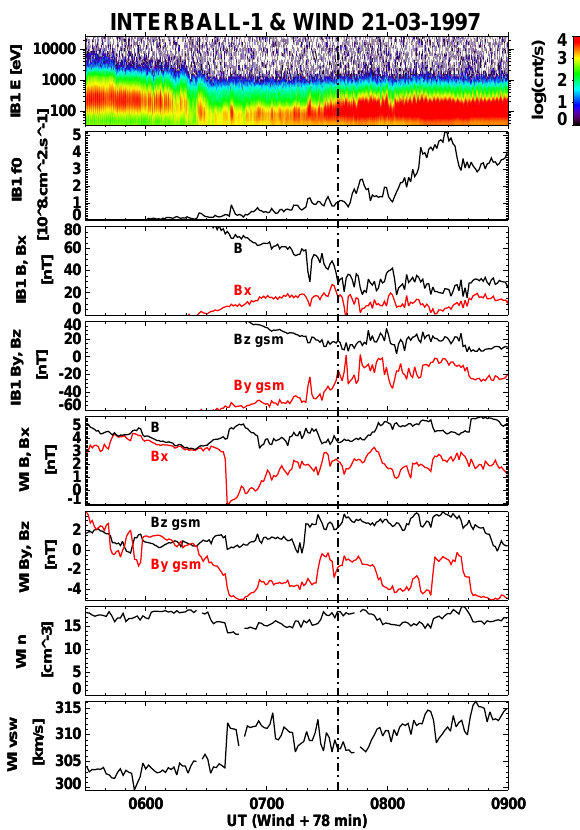
Fig. 1. Upstream conditions during the event under study (21 March 1997) measured by WIND (four bottom panels: the IMF B X com- ponent and magnetic field strength; IMF B Y and B Z components in GSM coordinates; the proton density; and the X component of the solar wind velocity). The electron energy spectrograms (top panel); the ion number flux (2nd panel) and magnetic field (3rd and 4th panels) registered on board INTERBALL-1 in the LLBL and outer cusp (until 07:35 UT) and in the magnetosheath. WIND data are shifted on ∼ 78min to account for a propagation